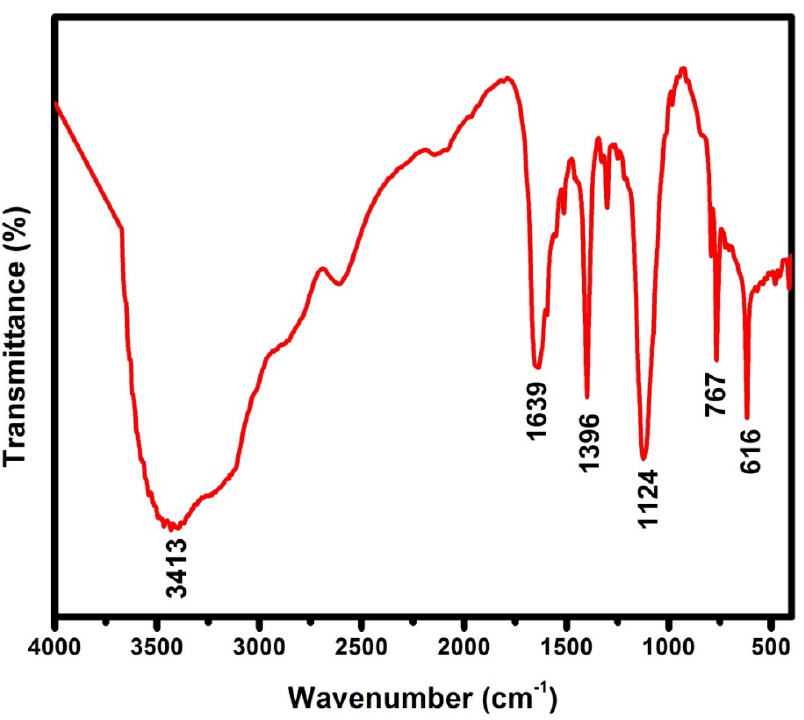
Figure 2. FTIR spectrum of as—synthesized PNA nanoparticles.